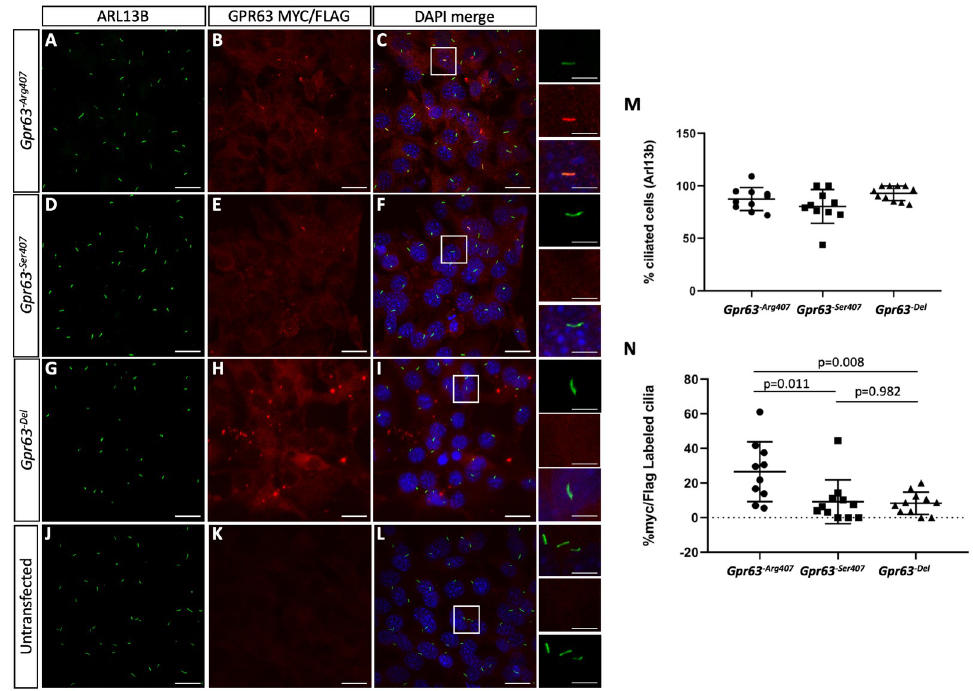
Fig 8. Ciliary localization is altered by overexpression of Gpr63 variants. NIH 3T3 cells were transfected to overexpress Gpr63 Arg407 (A-C), Gpr63 Ser407 (D-F) or Gpr63 Del (G-I) constructs. ARL13B was used as a marker of the ciliary axoneme. (J-L) An untransfected immunocytochemistry control is shown. Small panels show higher magnification of cells highlighted by white boxes to show cilia with robust, no, or little GPR63 immunoreactivity. (M) Expression of Gpr63 did not appear to affect the number of cells producing cilia. (N) Gpr63 Ser407 and Gpr63 Del constructs result in reduced ciliary accumulation of the epitope-tagged GPR63. Scale bars represent 20 μ m in A-L and 5 μ m in the inset panels.